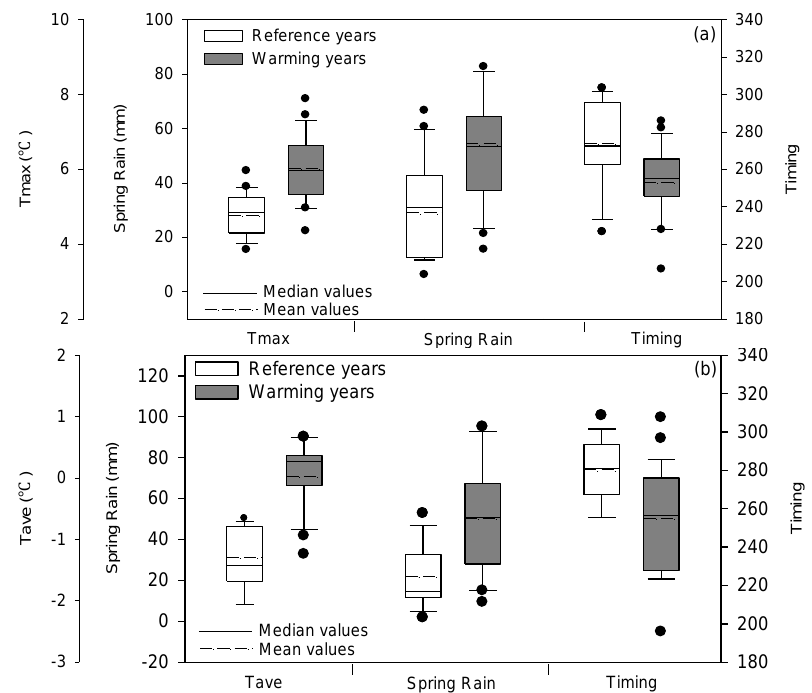
Figure 5. The box plot of T max , T ave , spring rain and high flow timing in pairing reference and warming years in the UHR ( a ) and GR ( b ) watersheds.